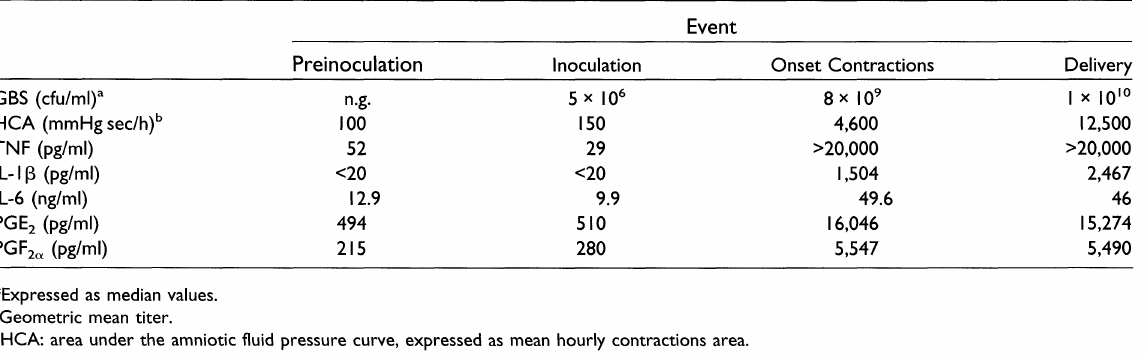
TABLE 2. Summary of amniotic fluid bacterial counts, cytokines and prostaglandin concentrations, and uterine activity in rhesus monkeys (n 4) with experimental intraaminiotic infection* Event Preinoculation Inoculation Onset Contractions Delivery